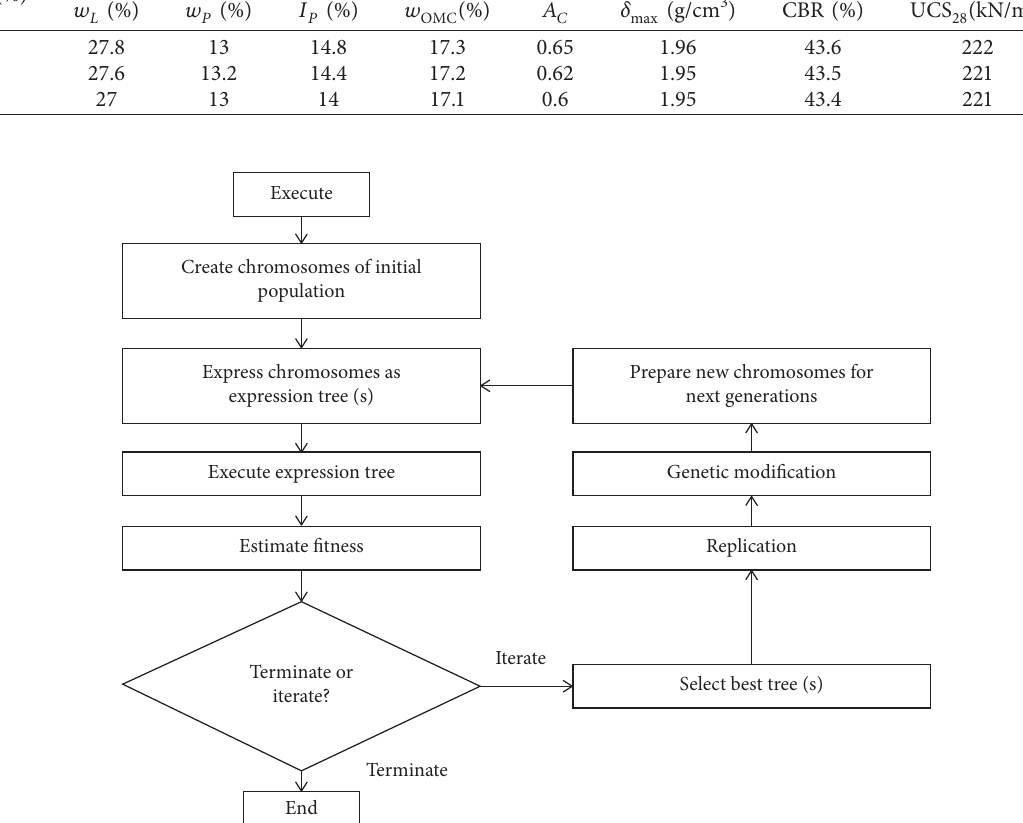
Figure 2: Flowchart of the GEP model